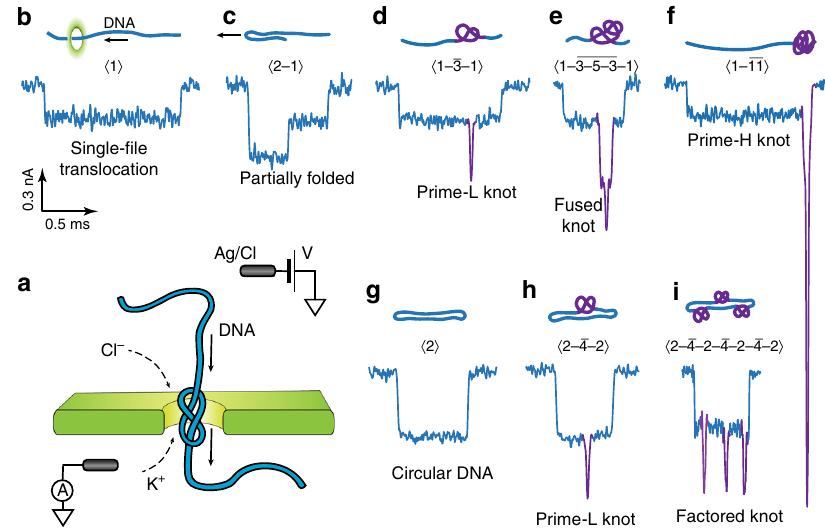
Fig. 1 Translocation events signatures of knotted and unknotted 48.5 kbp lambda DNA molecules. a Schematic image of the translocation of a DNA molecule through a nanopore. b – f Examples of the current blockade signals (events) assigned to linear DNA molecules in different con fi gurations, with corresponding sketch of DNA trajectory and SPIRaL designation. The unknotted parts of the signal and the sketch are color-coded with blue, while parts assigned to knots are presented in purple. g – i Similar signals assigned to knots on circular DNA molecules. A rare factored composite knot comprising of three factor knots is depicted in panel i . All events are plotted on the same scale; time-current scale is presented in the fi